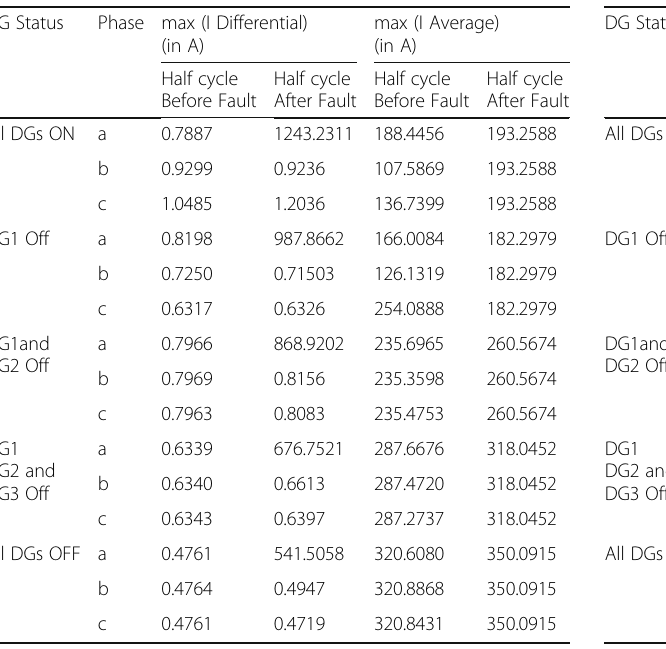
Table 2 Effect of variation of penetration level of the DG ’ s on the magnitude of fault current (differential and average) at distribution Line DL AB for a triple line to ground fault (abc-g) fault on at